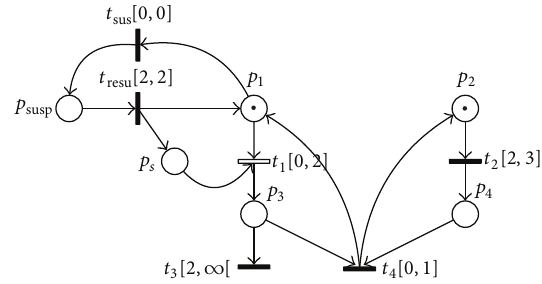
Figure 12: Clock evaluation of 𝑡 1 in the controlled TPN of Figure 10. Forbidden interval is ]𝛼 1 ,𝑏] where 𝑎 ≤ 𝛼 1 < 𝑏 .